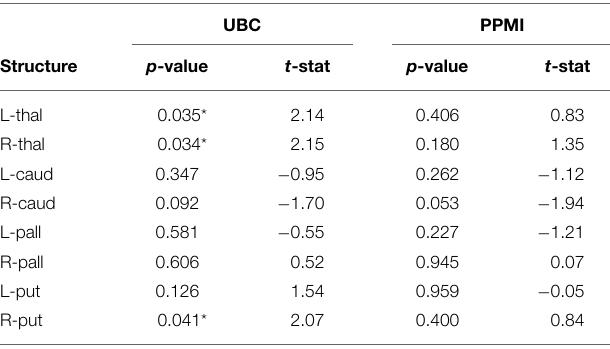
TABLE 3 | Results for the analysis of group level difference in the volume of the subcortical structures between the participants in the Parkinson’s disease and healthy control